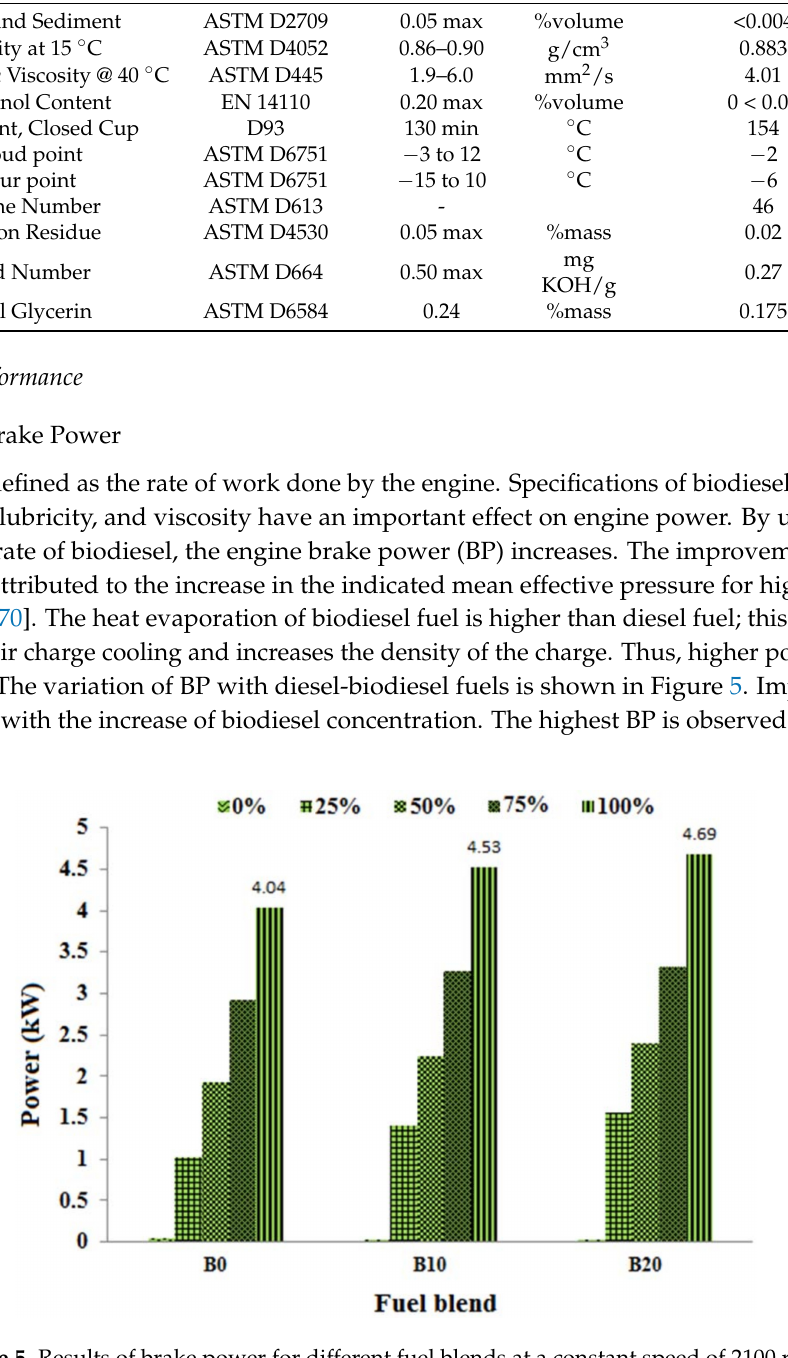
Figure 5. Results of brake power for different fuel blends at a constant speed of 2100